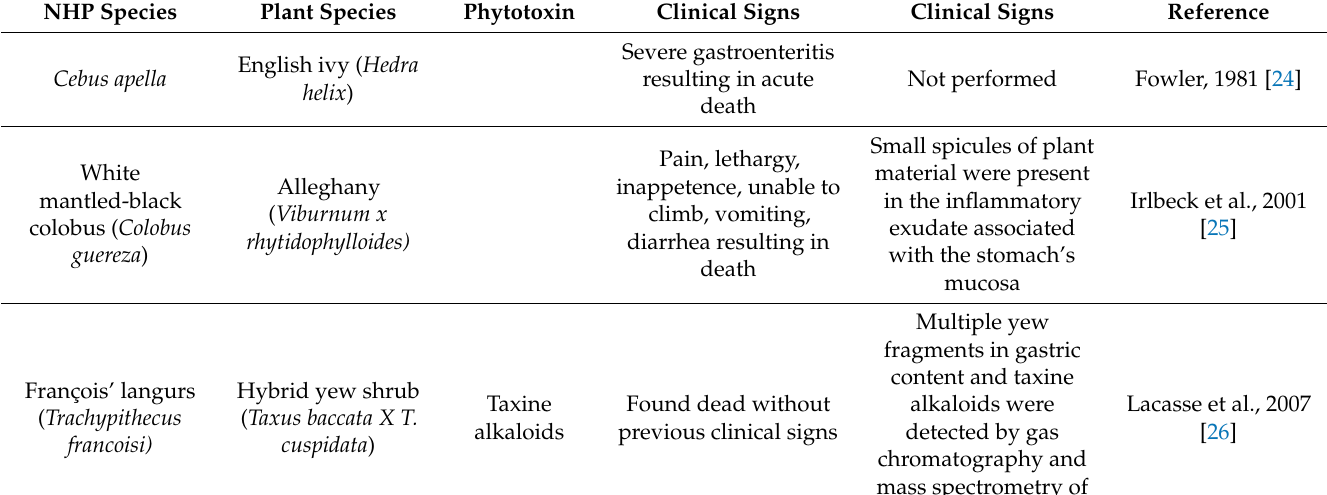
Table 2. Cases of unintentional phytotoxin poisoning in captive